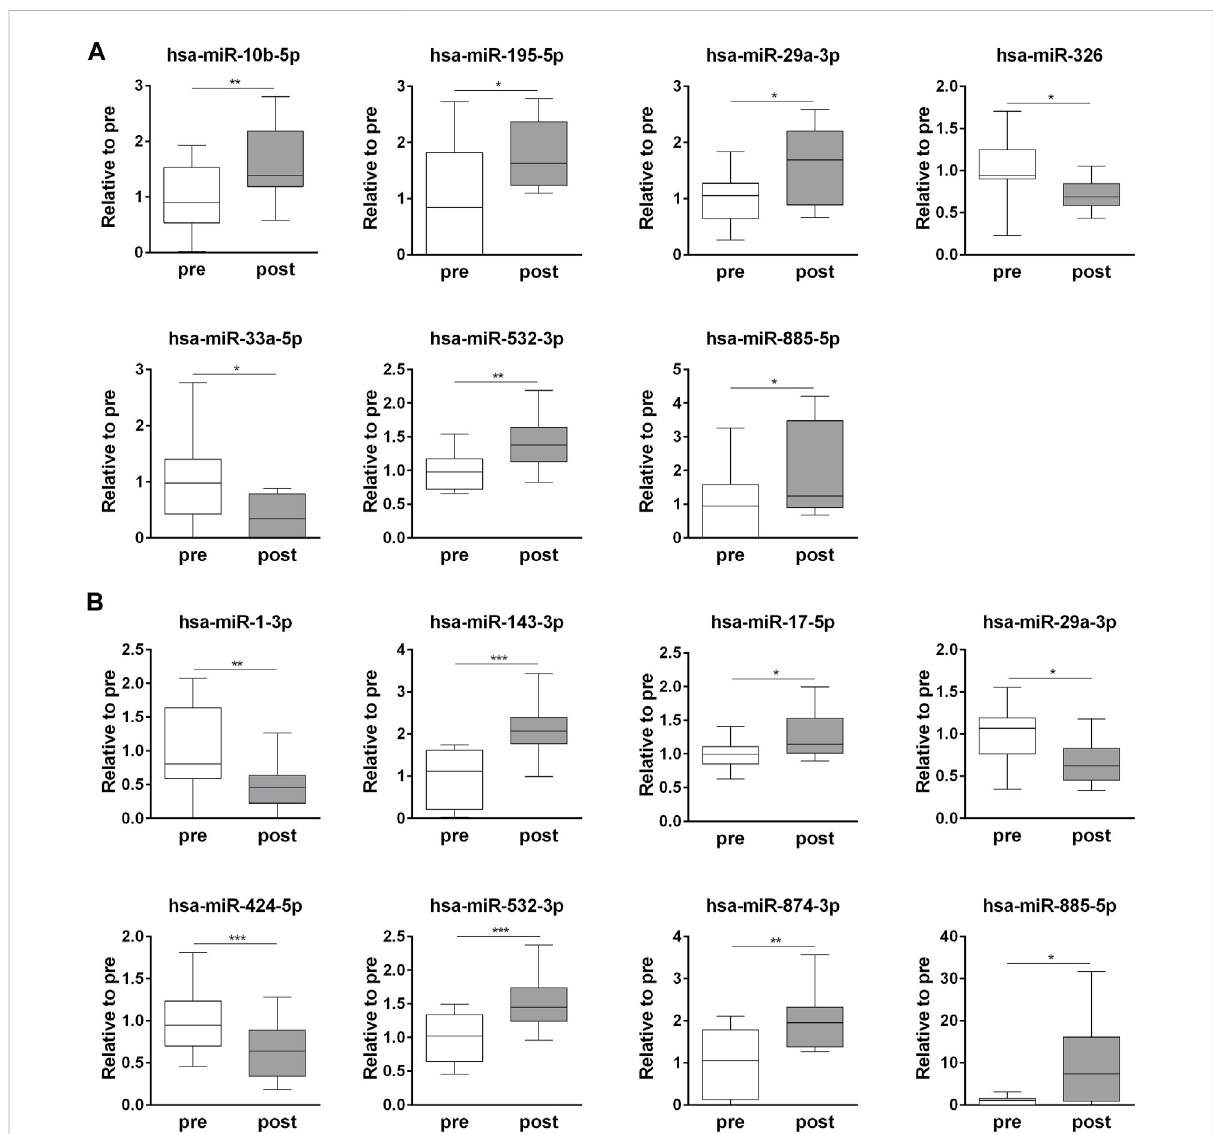
FIGURE 2 Endurance exercise-dependent changes in circulating plasma t-miRNAs and EV-miRNA. Fold change (post-competition vs. pre- competition) ofplasma (A) t-miRNAsand (B) EV-miRNAs( ≥ ±5fold, p < 0.05),validatedineachplasmasample.StatisticalanalysiswasperformedwithPrism ® v6.01 (GraphPadSoftware).Alldataareexpressedasmin.tomax.andcomparedusingapaired t -test.Thedifferenceswereconsideredsigni fi cantwhen p < 0.05. Asterisks indicate signi fi cant intergroup differences (* p < 0.05, ** p < 0.01, *** p <